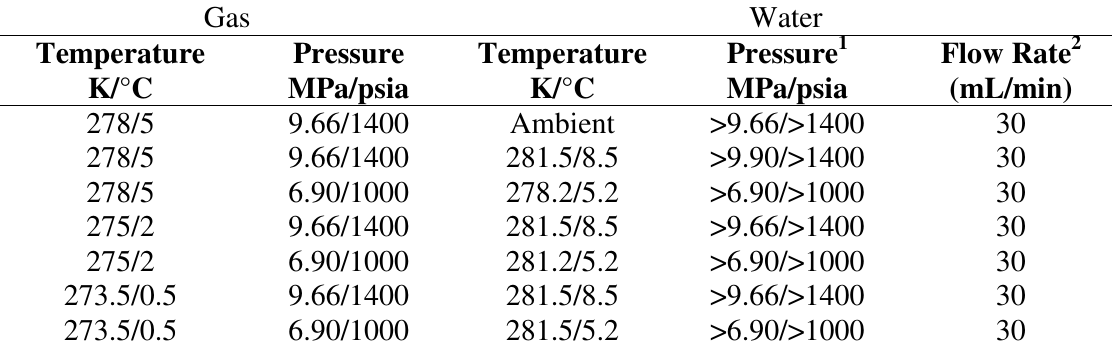
Table 4. Rapid methane hydrate formation experimental test matrix.